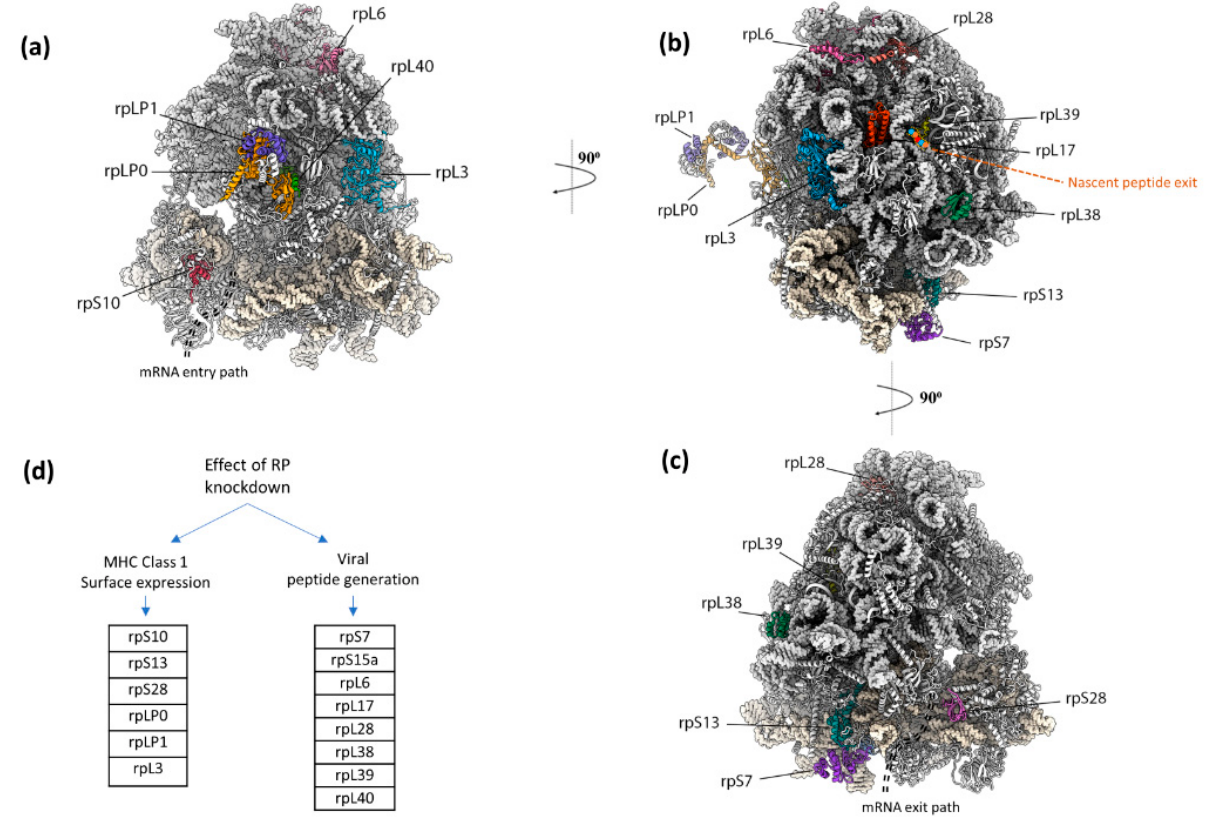
Figure 6. Ribosomal proteins that impact MHC Class 1 peptide generation for immunosurveillance, according to Wei et al. 2019 [192]. ( a – c ) Depiction of ribosomal proteins that impact MHC Class 1 peptide generation for immunosurveillance [192]. rpL6 and rpL28, which are adjacent to each other on the large subunit, have opposing effects on viral peptide generation. rpL6 depletion decreases ubiquitin ‐ dependent peptide presentation, whereas rpL28 depletion increases ubiquitin ‐ dependent and ‐ independent peptide presentation. Figure was generated with a human ribosome (PDB 4V6X) in ChimeraX. ( d ) Individual ribosomal protein knockdowns affect immunosurveillance by impacting either MHC Class 1 surface expression or viral peptide generation, and are grouped as reported.